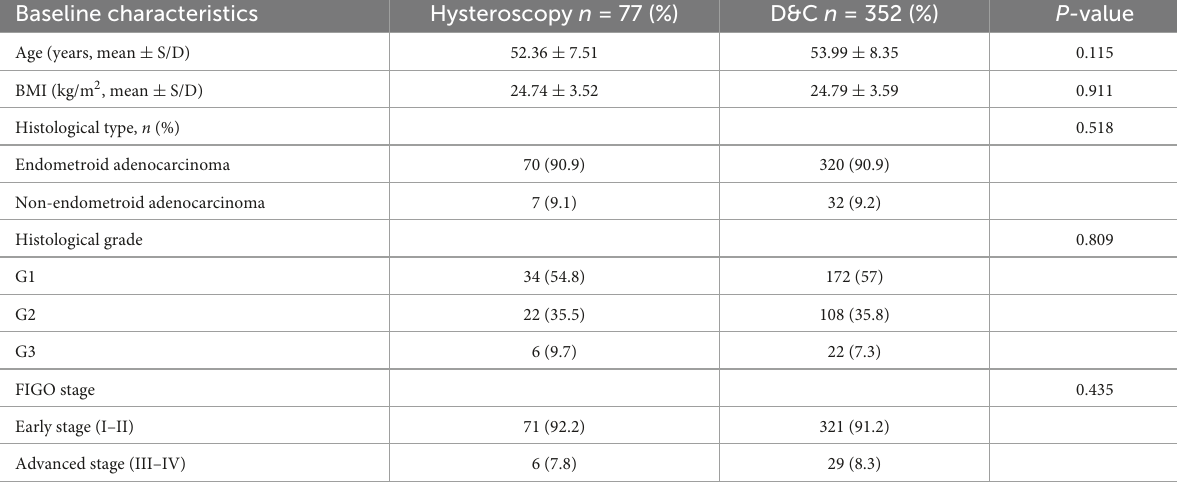
TABLE 1 Baseline characteristics of HSC and D&C.